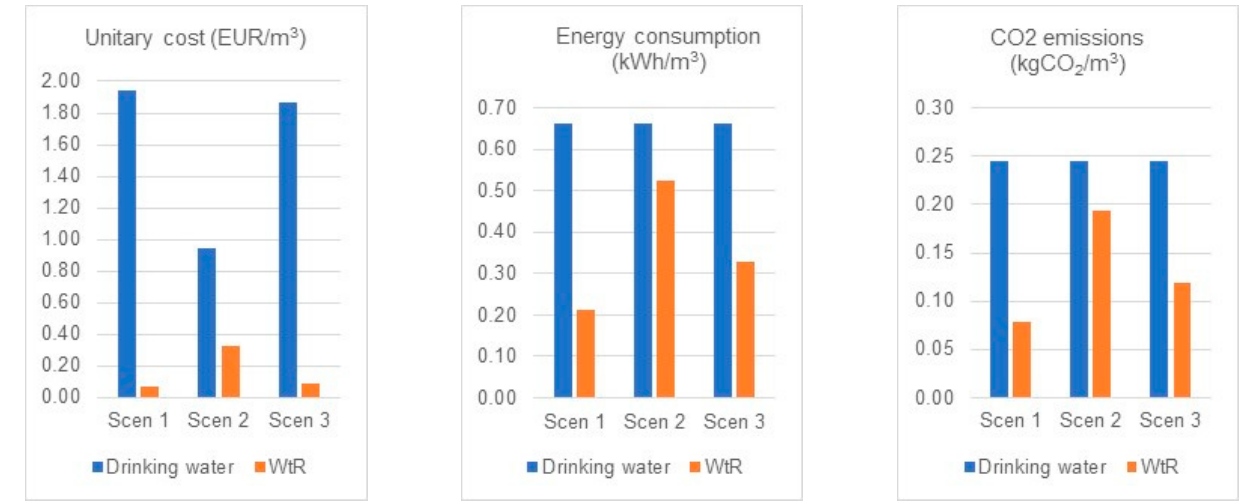
Figure 9. Unitary cost, energy and CO 2 emissions considering a supply with drinking water and with WtR.